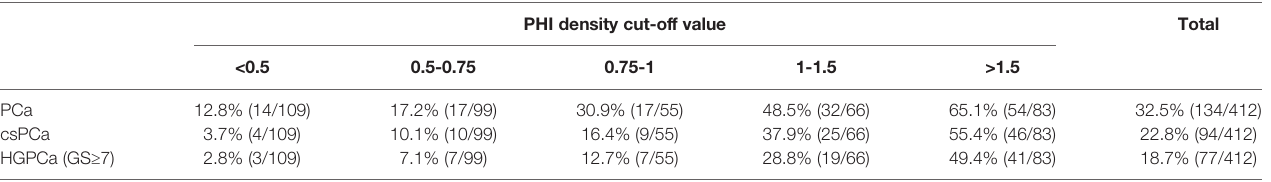
TABLE 4 | Percentage of PCa, csPCa, and high-grade PCa (HGPCa) diagnosed at different PHI density values.